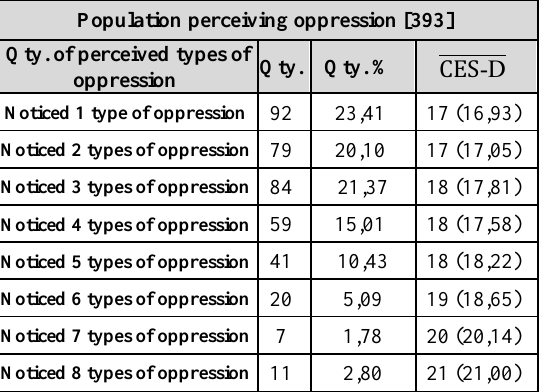
Table 5 : Types of oppression and their occurrence, by population Population perceiving oppression [393] Qty. of perceived types of